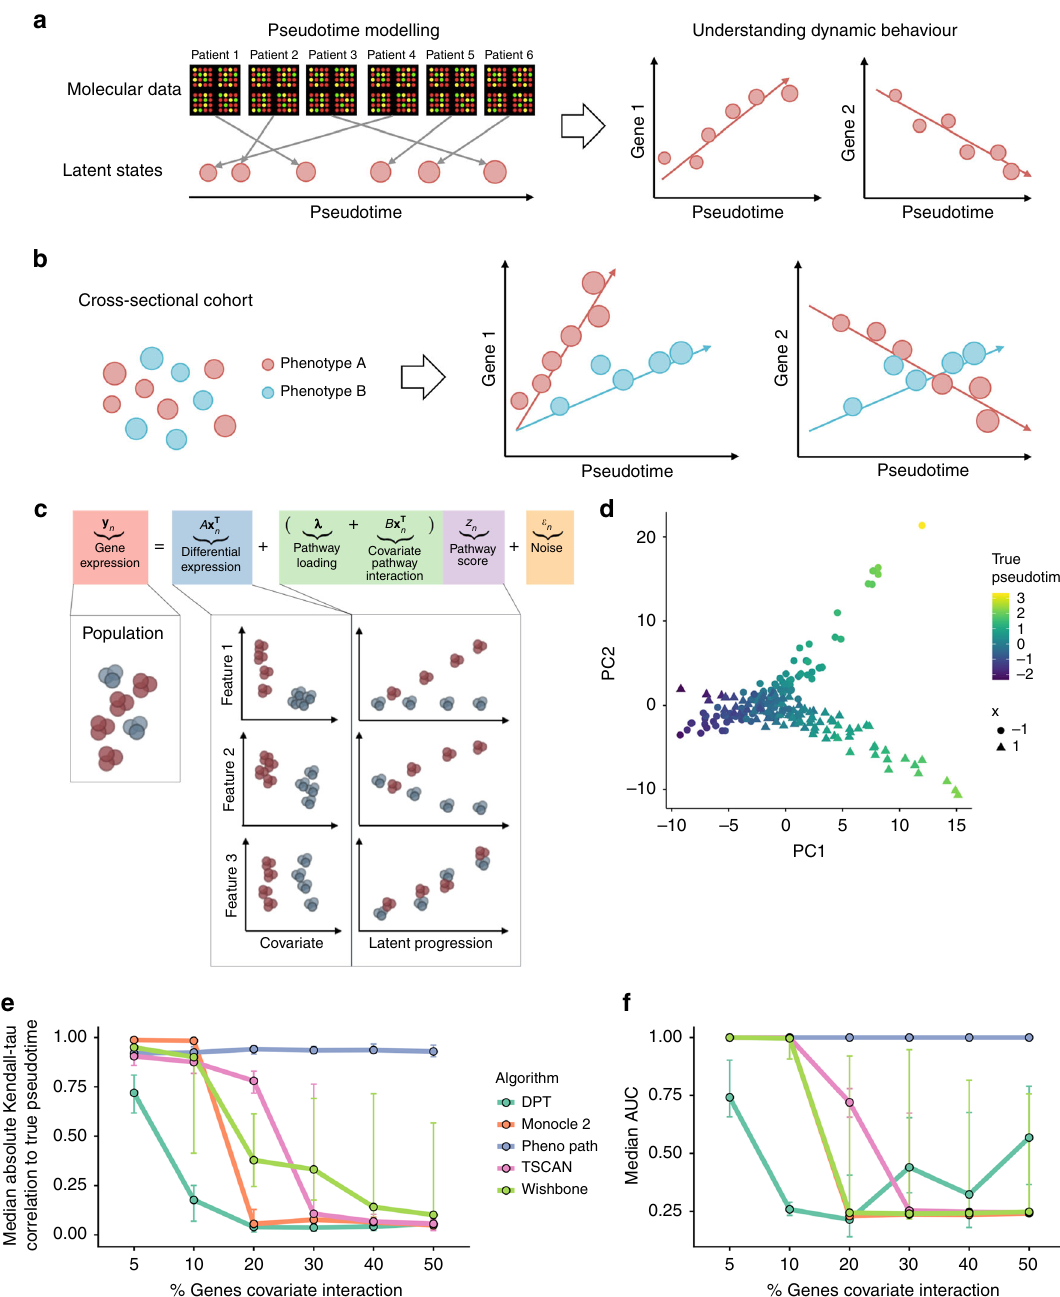
Fig. 1 An illustration of pseudotemporal analysis. a High-dimensional molecular data from a cross-sectional cohort is mapped on to a one-dimensional pseudotemporal progression scale allowing pseudotemporal behaviour of individual features to be analysed. b If the cohort contains sub-populations we may want each sub-population to be associated to distinct trajectories. c PhenoPath models observed expression as a combination of standard differential expression and pseudotime/pathway effects, including covariate-pathway interactions. d PCA representation of a simulated data set coloured by pseudotime shows a clear splitting of trajectories between covariate status x = ( − 1, 1). e Median Kendall- τ correlation to true pseudotime across varying fractions of genes exhibiting covariate-trajectory interactions on simulated data. PhenoPath is the only algorithm for which the accuracy of inference is independent of the (unknown) fraction. f Median AUCs measuring the accuracy of different approaches to detecting covariate-trajectory interactions using Limma Voom for differential expression analysis. As before, PhenoPath is the only algorithm for which the accuracy is independent of the underlying fraction of genes exhibiting covariate-trajectory